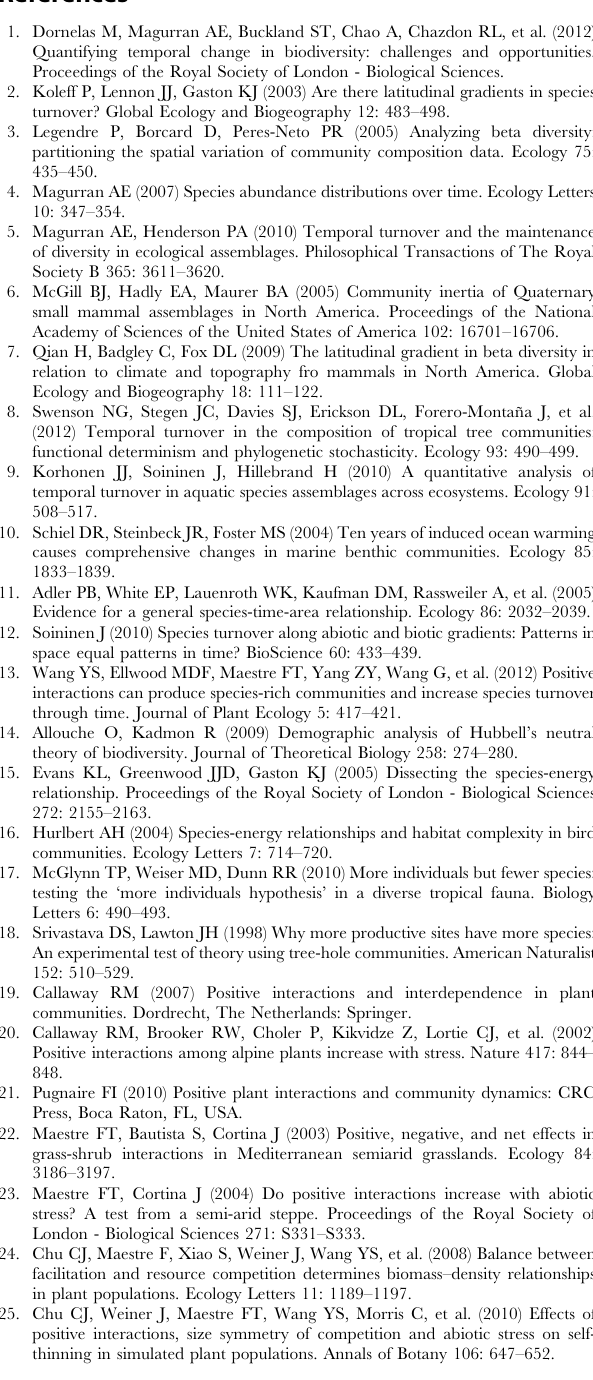
values are the same as in Fig. 1. Each data point represents the mean 6 SE. The R 2 of the quadratic regression is 0.9256. (TIF) Figure S9 The relationship between the mean population size (MPS) and the Bray-Curtis similarity index for communities with (CFM-U, and CFM-L) and without (CM) facilitation. The parameter values are the same as in Fig. 1. Each data point represents the mean 6 SE. The R 2 of the quadratic regression is 0.8585.